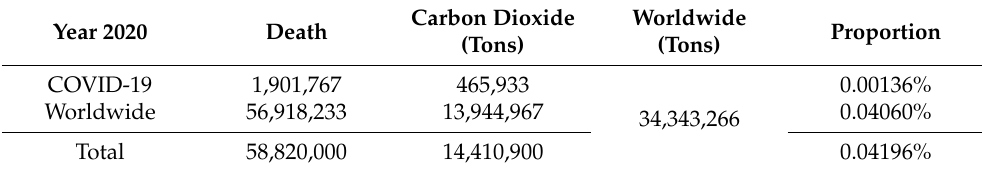
Table 3. Worldwide deaths including COVID-19, and the resulting carbon dioxide versus global figures.